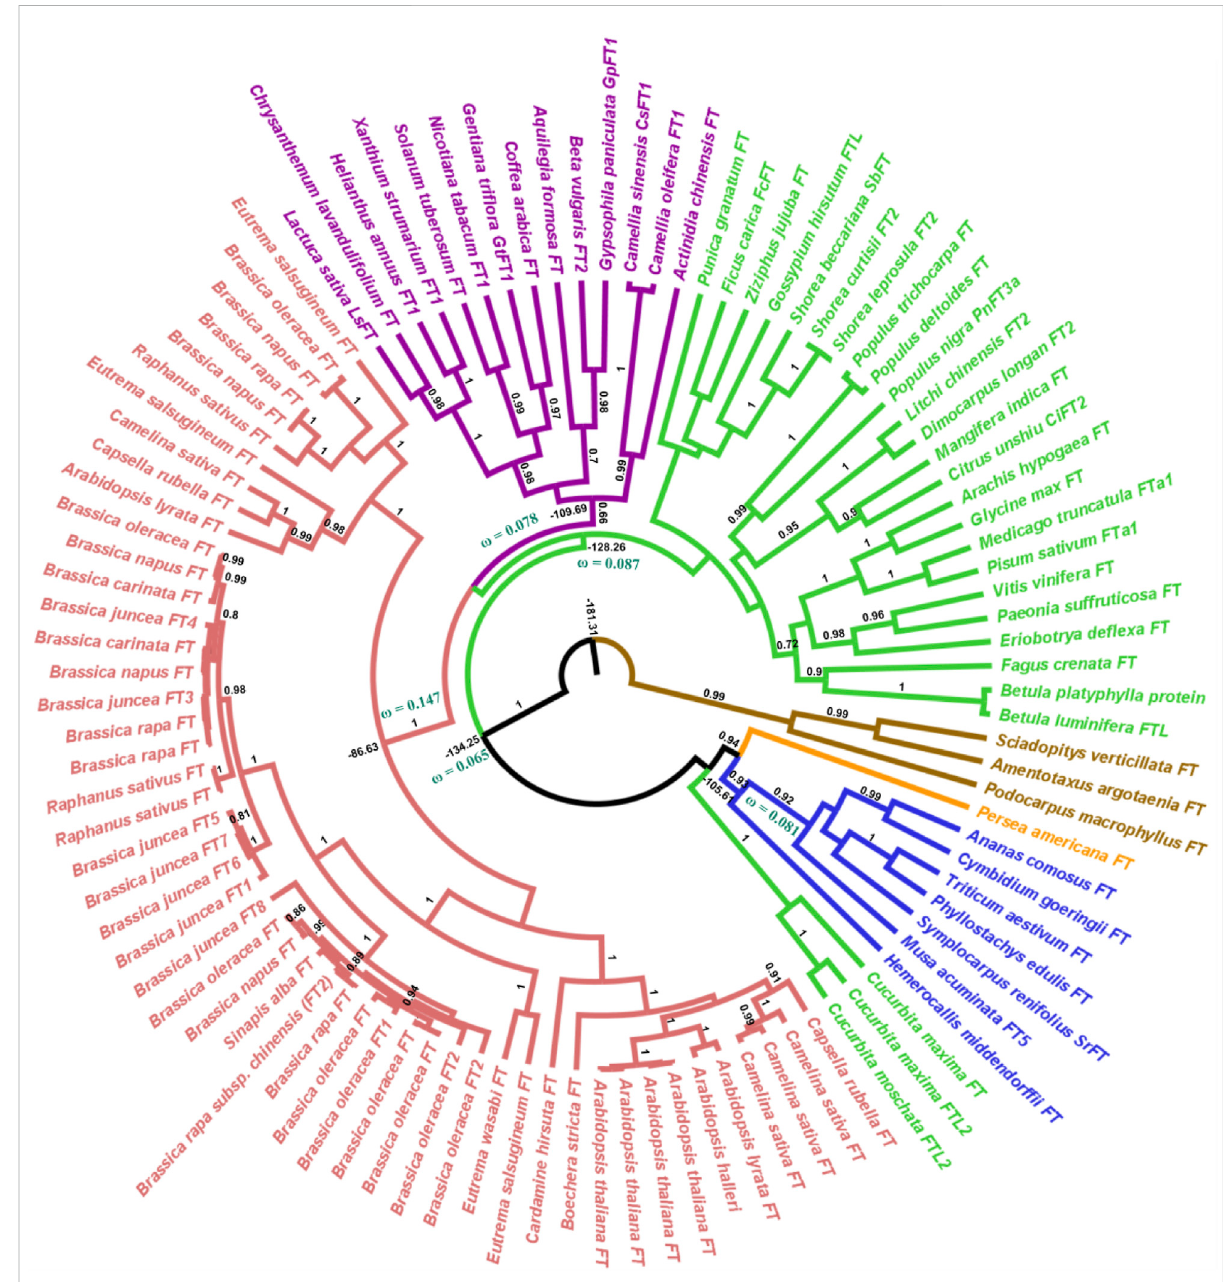
FIGURE 1 Bayesian phylogeny of angiosperm FT sequences. The major branches are indicated by posterior probability. Molecular dating and the dN/dS ratios represented by the ω value are observed in the major clades. Colors indicate the clades, red = brassicales, purple = asterids, green = eudicots, blue = monocots, orange = Magnoliidae, brown = external group. The brassicales, asterids, and eudicots clades (red, purple, and green) form the ancestor of